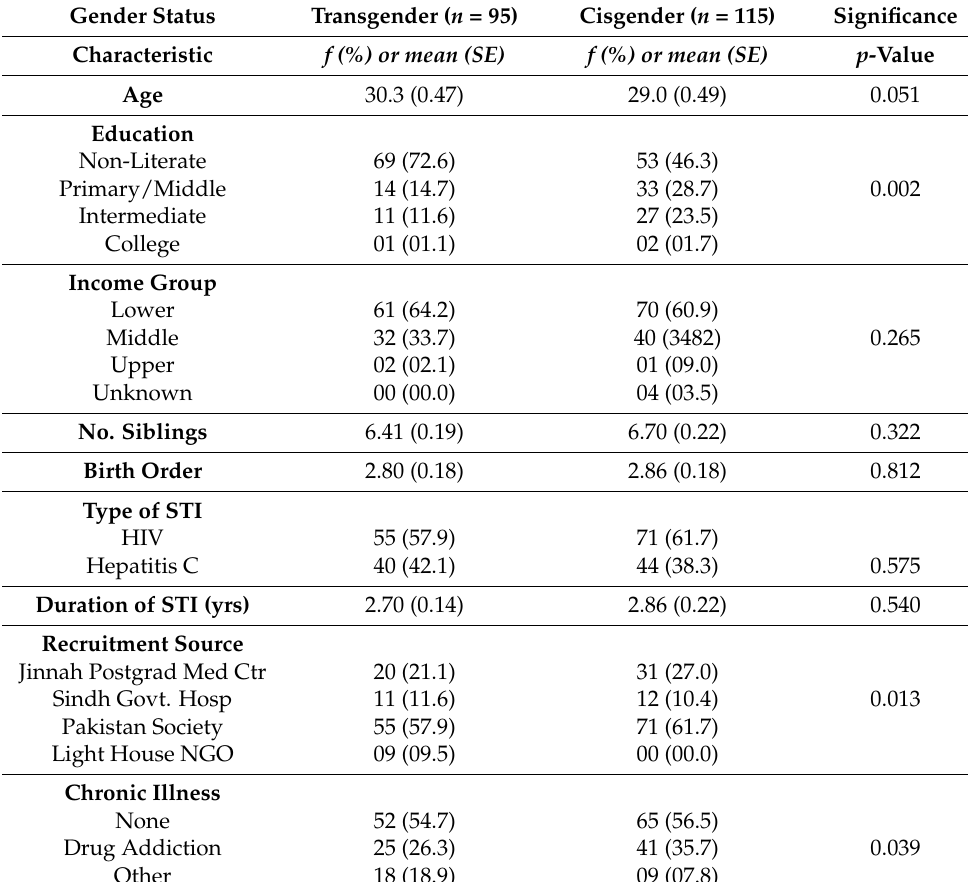
Table 1. Demographic and medical characteristics of